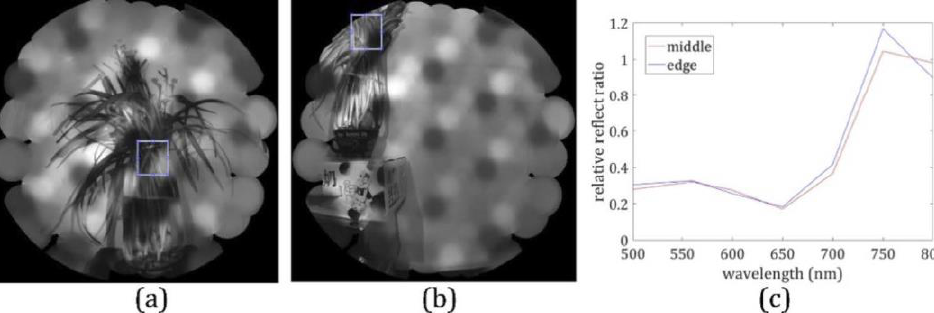
Figure 51. MSI of the BMCCEC prototype in the whole FOV: ( a ) reconstructed multispectral image in the central FOV, ( b ) reconstructed multispectral image in the edge FOV, ( c ) retrieved reflection spectrum curves for multispectral images in different FOVs.